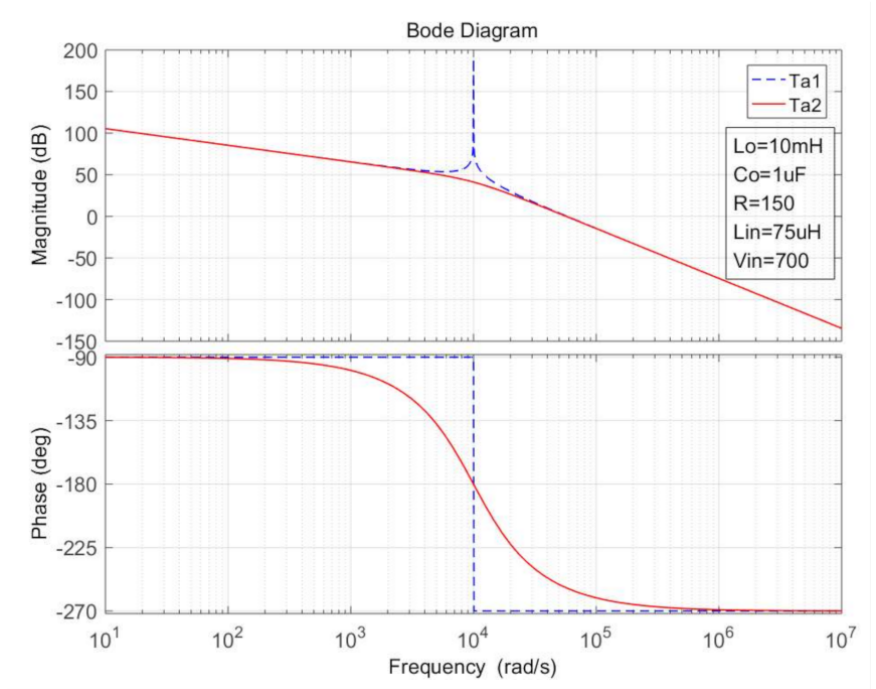
Figure 15. Loop gain before